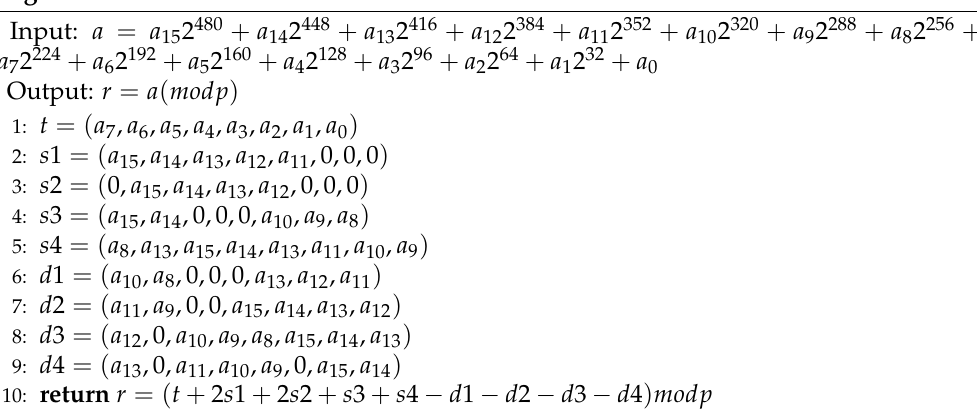
Algorithm 6 Fast Modular Reduction for NIST P-256.